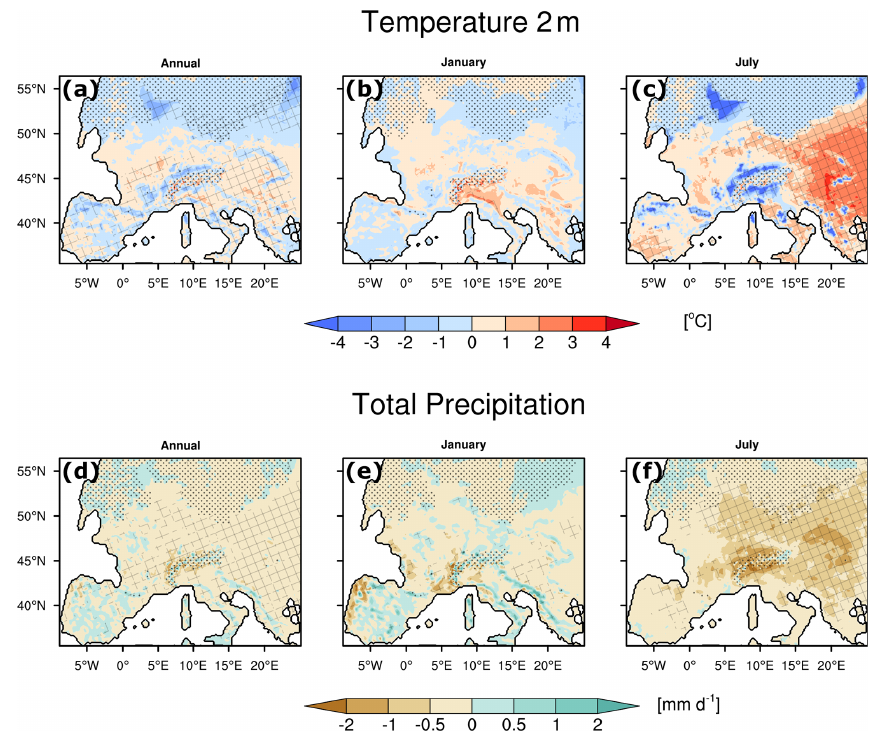
Figure 7. Atmospheric response to changes in the land cover. Panel (a) shows differences in the annual mean temperature between LGM LGM – LGM PD . Panels (b) and (c) are the same as (a) but for January and July, respectively. Panels (d) , (e) , and (f) are the same as (a) , (b) , and (c) but for precipitation. The solid line represents the coastline during the LGM, stippled areas are covered by glaciers, and crosshatched areas indicate statistically significant differences using a two-tailed bootstrapping technique with a 2% significance